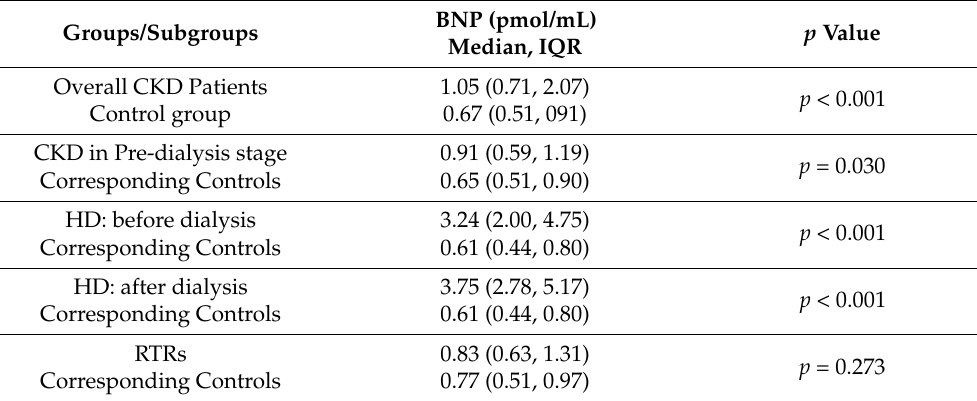
Table 3. Comparison of BNP levels (Median, IQR) between groups and subgroups of the study *.